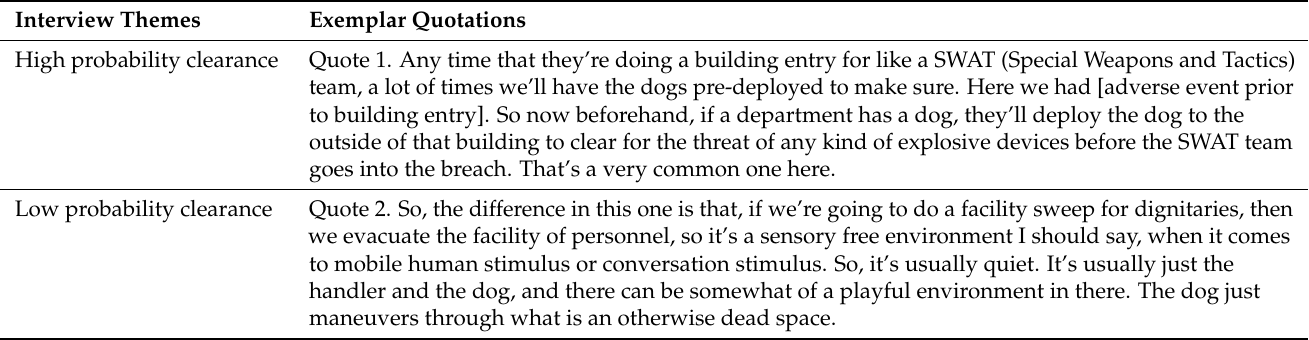
Table 1. EDC utilization interview themes and exemplar